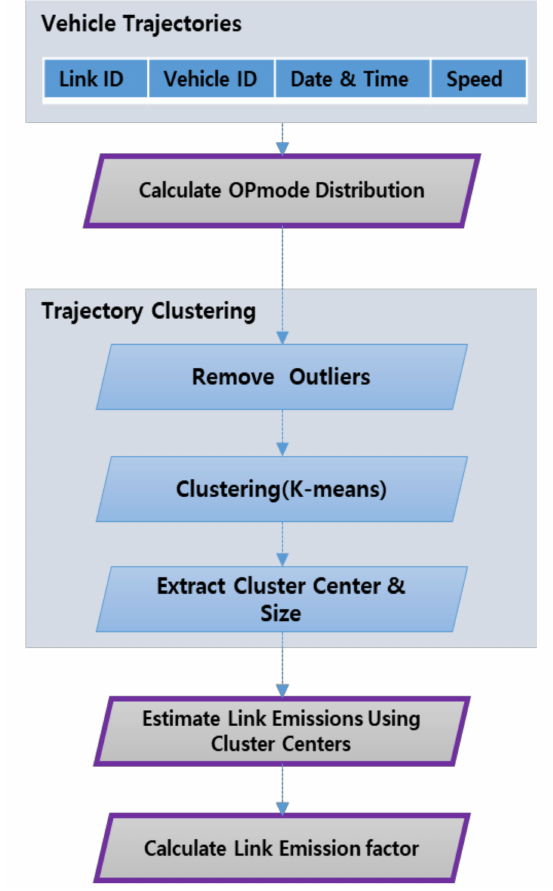
Figure 1. Process of Developing Link Emission